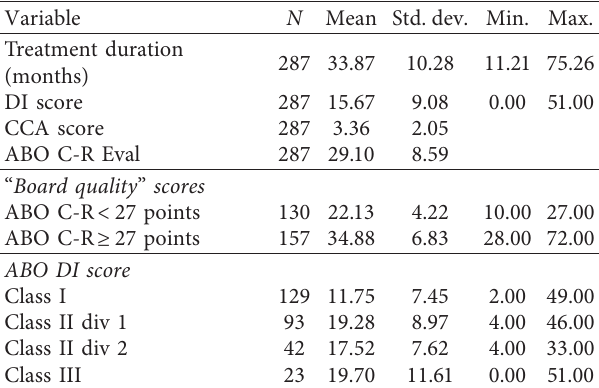
Table 3: Mean treatment duration, ABO DI scores, and treatment